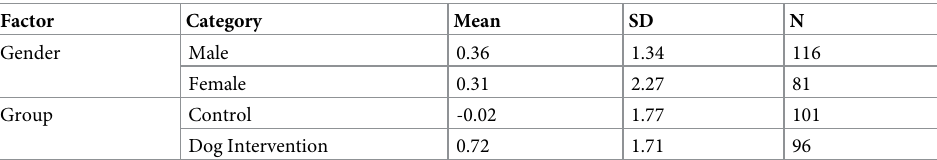
Table 10. Descriptive statistics for